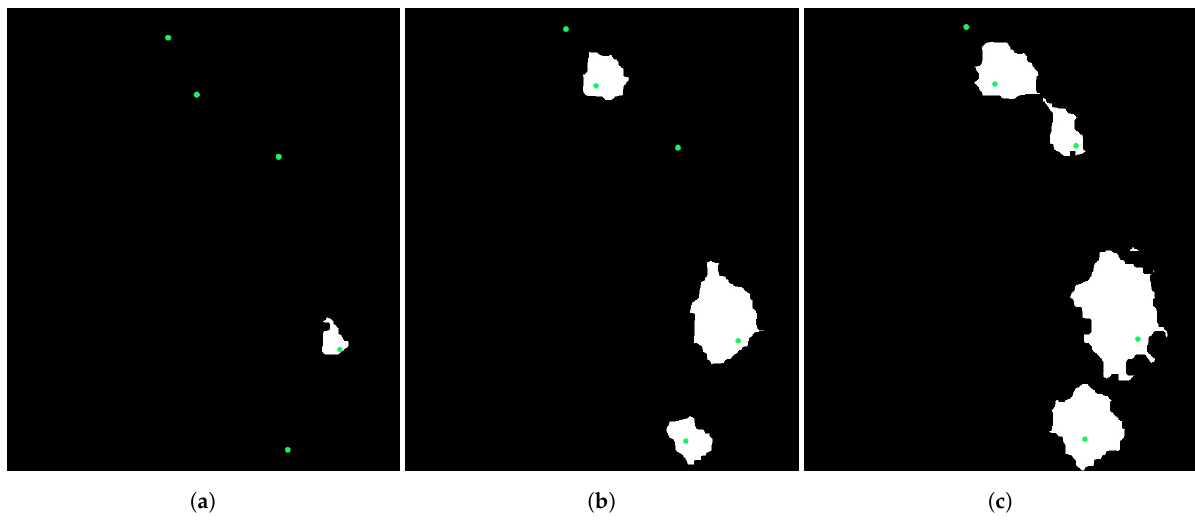
Figure 5. Green pixels contain the real treetops, white pixels contain the mask of the part of the nDSM that is being considered. For each position of the sliding window, only the top intensities are considered (step 1). Every time a new connected component appears, its area is considered. If the area is large enough, a treetop is predicted in the pixel with higher nDSM intensity. Subsequently, a widening range of intensities is taken into account and the connected components not yet containing predicted treetops are considered. In ( a ) step 1, one fir tree is detected, ( b ) in step 2, two more are detected and finally ( c ) in step 3, one more is